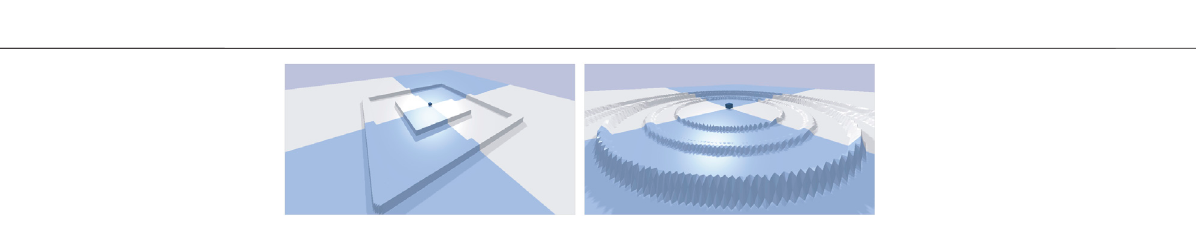
Frontiers in Robotics and AI |